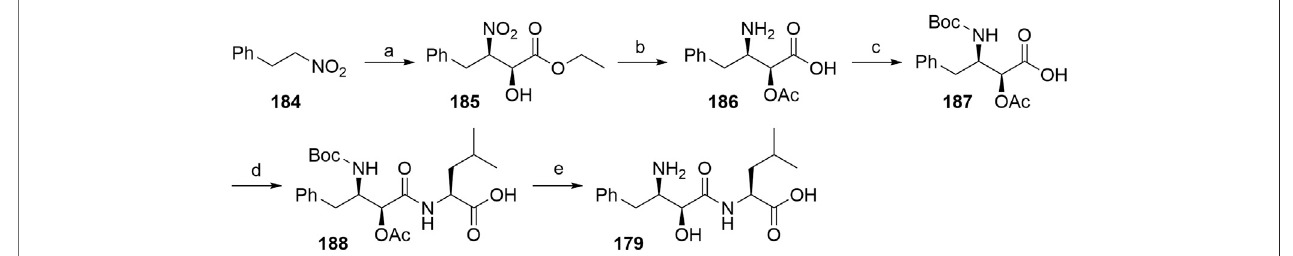
SCHEME 32 | The synthesis of bestatin ( 179 ) (Gogoi et al., 2005). Reagents and conditions: a) ethyl glyoxalate, La-( R )-BINOL, THF, – 50 ° C, 81% yield, 93% ee; b) i. acetylation, 94% yield (no detailed reagents given); ii. Pd/C, NaBH 4 , H 2 , MeOH, 60%, 93% ee; c) (Boc) 2 O, NaHCO 3 , H 2 O, EtOAc, 92% yield; d) i. L -leucine benzyl ester, N -ethylmorpholine, isobutylchloroformate,THF, – 10 ° C;ii.Pd/C,H 2 , MeOH, 77%yield overtwo steps; e) i.K 2 CO 3 , MeOH; ii. TFA,73% yieldover twosteps(Gogoietal., 2005).